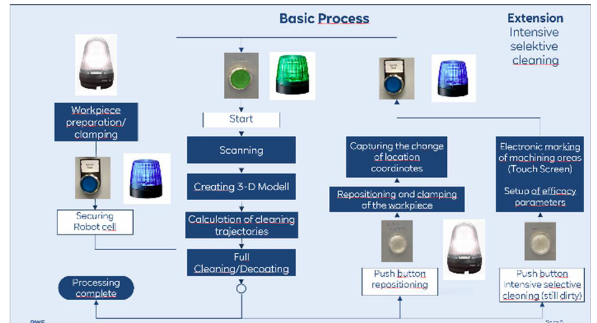
Fig. 9. Elegance lies in Simplicity: Final Process Workflow and User Interface.